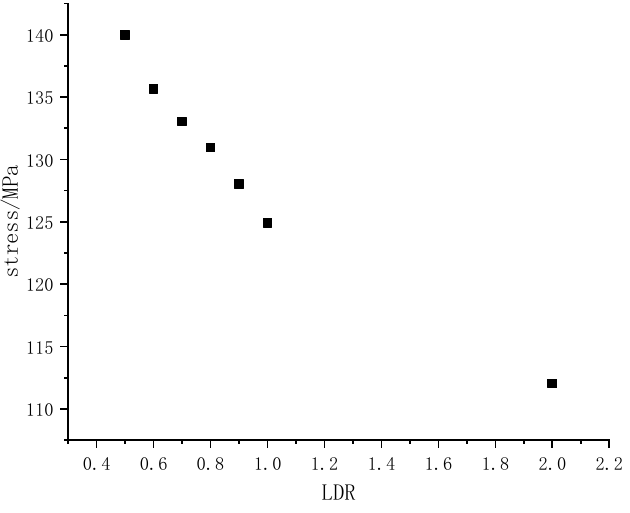
Figure 2. Static rock strength of different sizes.